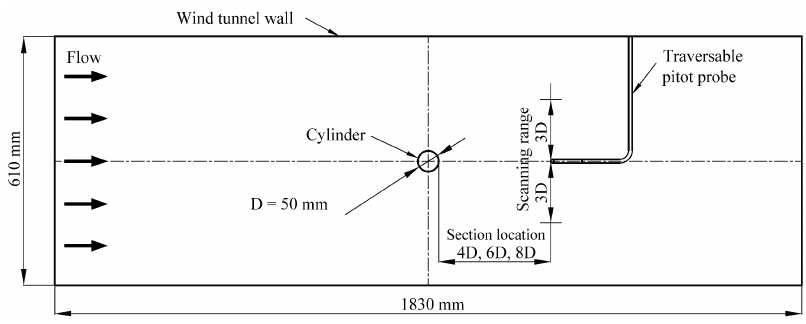
Figure 3. A schematic of the wake survey setup in the test section.